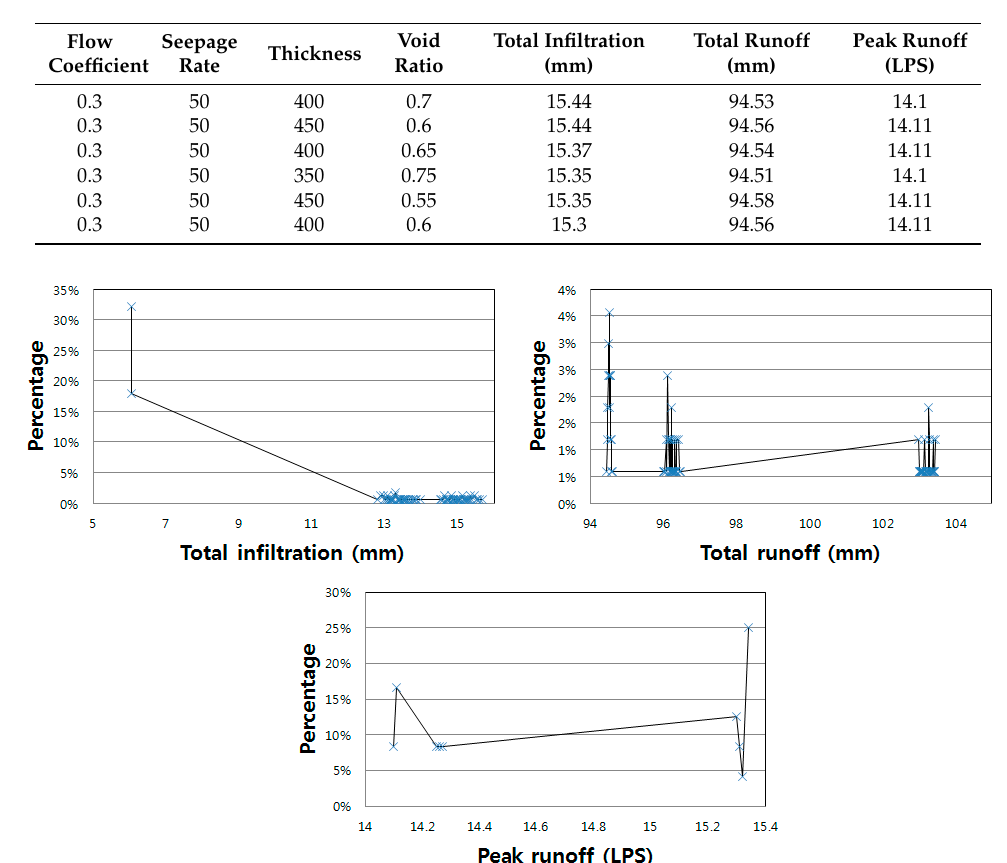
Figure 4. Graph of the relative frequencies of the simulated scenarios.